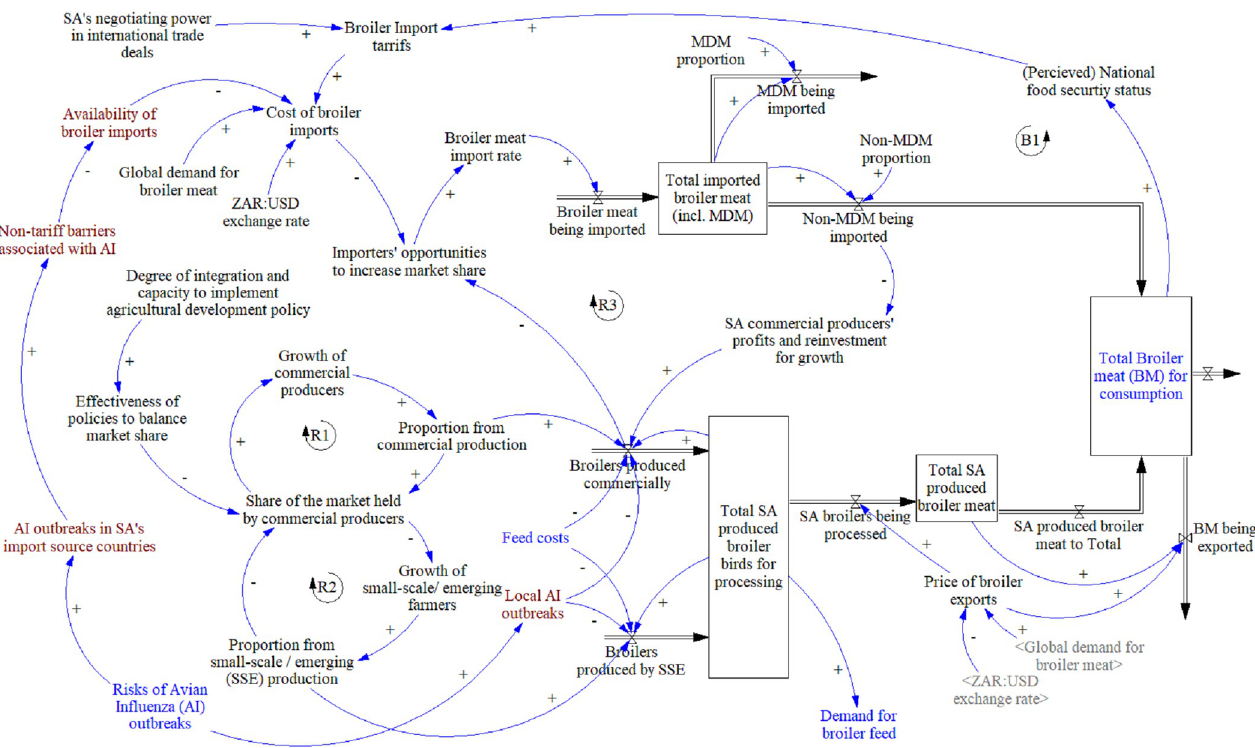
Fig 3. Broiler production and imports module. Key: Blue text: elements linking to other modules, Brown text: elements added after meeting with stakeholders, Grey text between < > are duplicated variables within the module. Abbreviations: AI = Avian Influenza, MDM = mechanically deboned meat, SA = South Africa(n), SSE = Small-scale and emerging, USD = United States Dollar, ZAR = South African Rand.